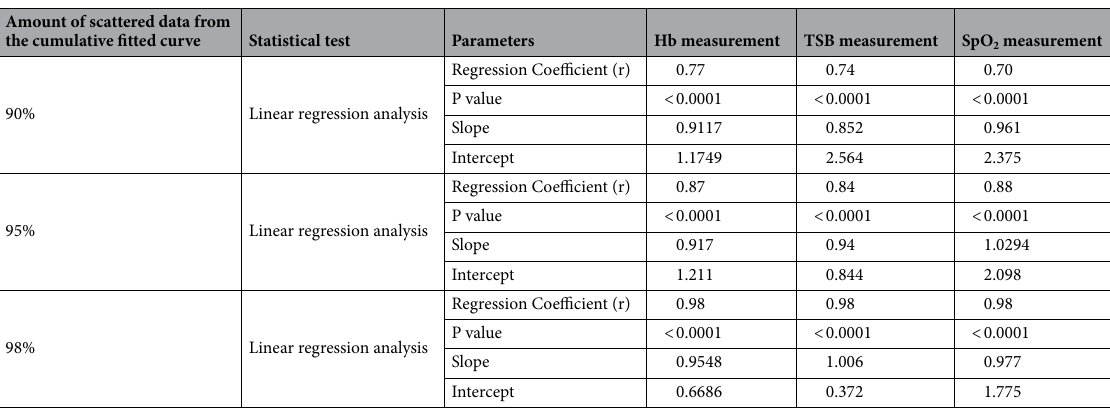
Table 1. Statistical parameters defining the correlation of the three partitions of the calibration dataset (see text for details) with the three blood